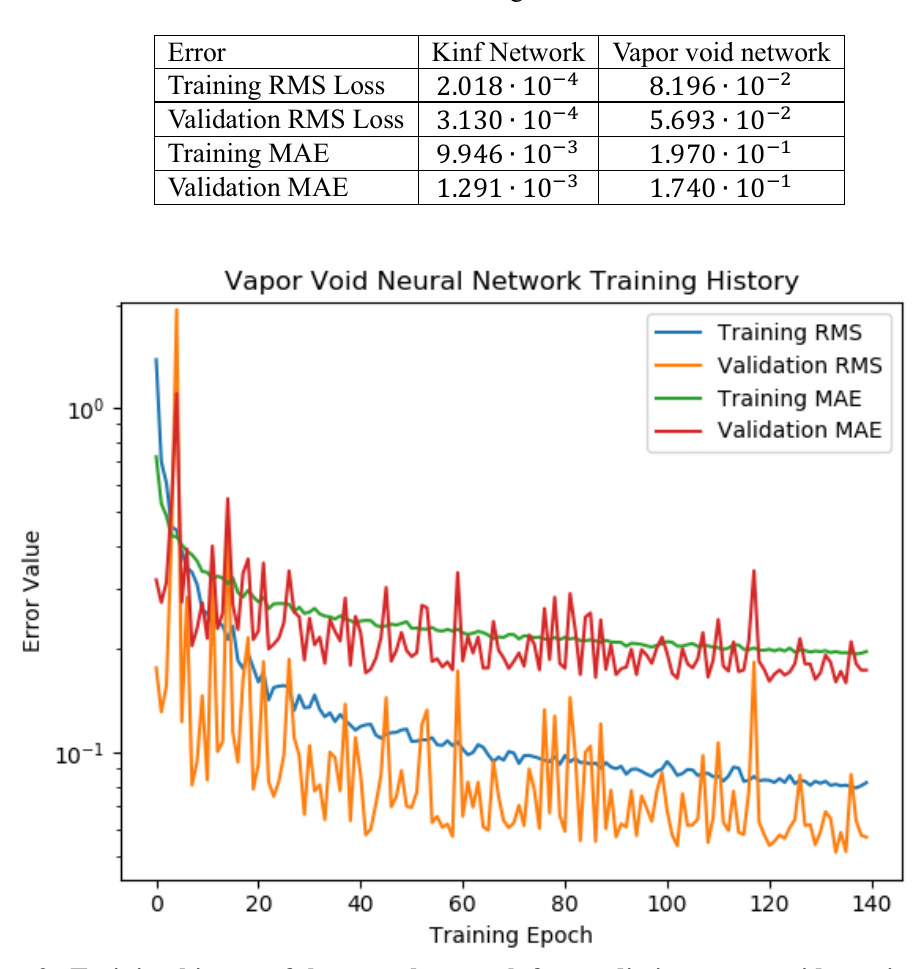
Table V. Losses: Final Training Loss Values for the ANNs.